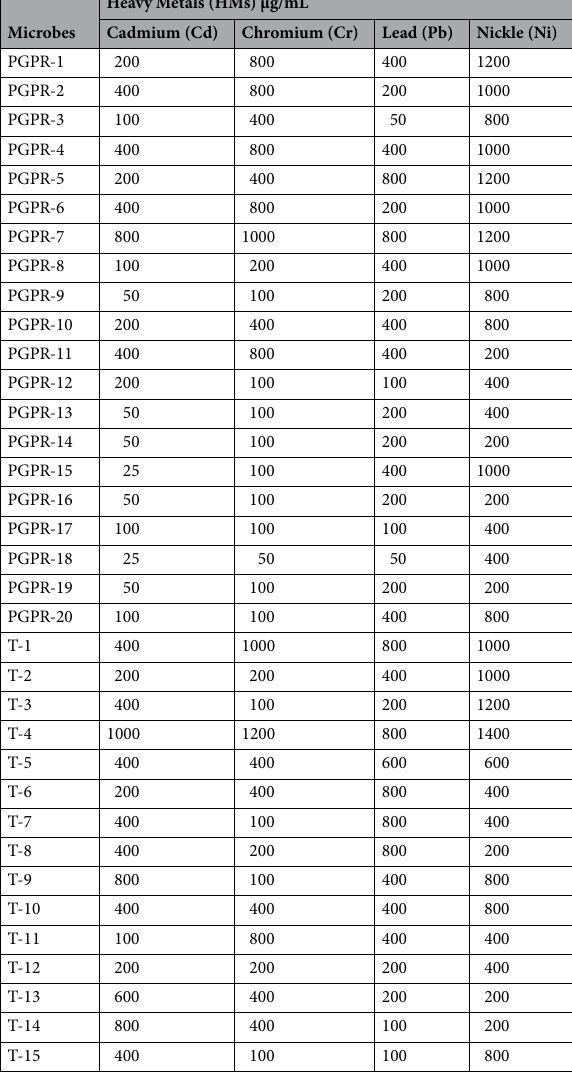
Table 1. Tolerance of heavy metals (HMs) to isolated PGPR and